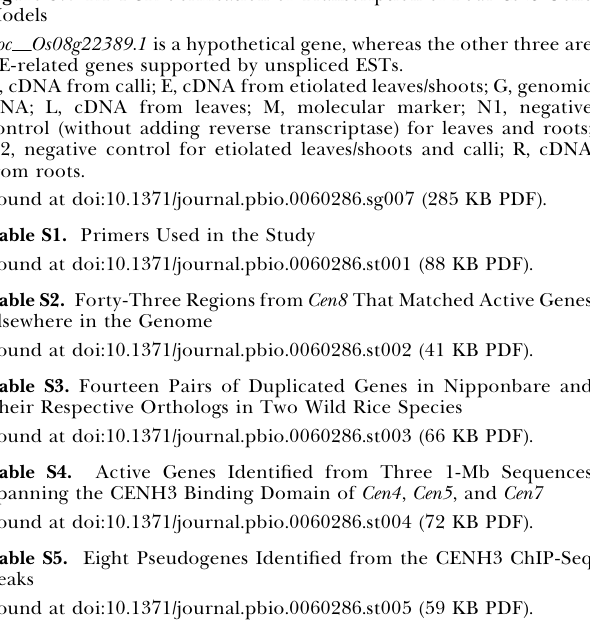
Figure S6. Verification of the CENH3 Binding for Eight Genes Located within the CENH3 Subdomains The five genes on the left side are supported by ESTs, and the other three are hypothetical genes. Relative enrichment was calculated and tested for significance as in Figure S3. Real-time PCR confirmed the CENH3 binding for all eight genes. Figure S7. RT-PCR Verification of Transcription of Four Cen8 Gene Models